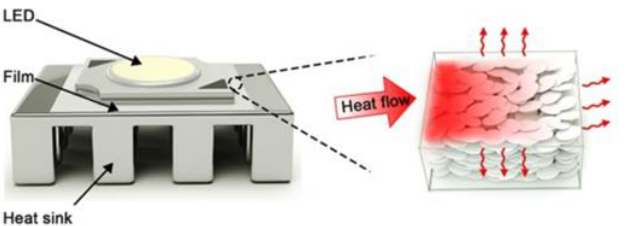
Figure 6. Schematic diagram of heat conduction in a BN film. Adapted with permission [44], Copyright 2021, Applied Nano Materials.